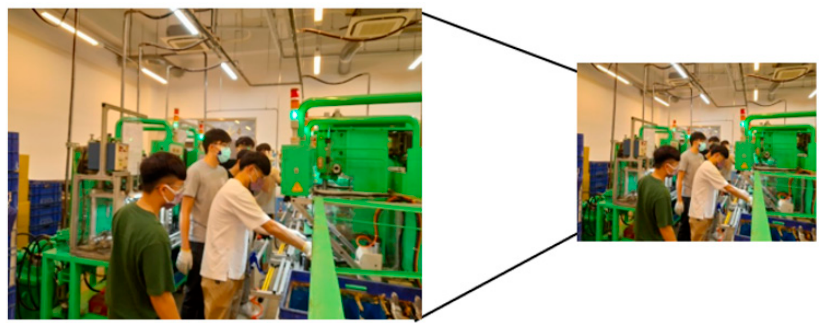
Figure 10. The output of image resizing (from 1831 × 1373 to 416 × 312).